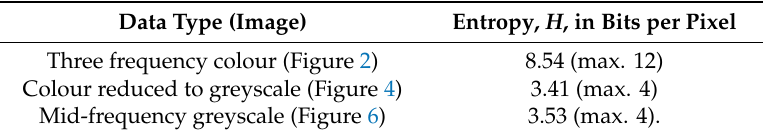
Table 4. Average information per pixel (information entropy) in the three frequency colour image and in the greyscale